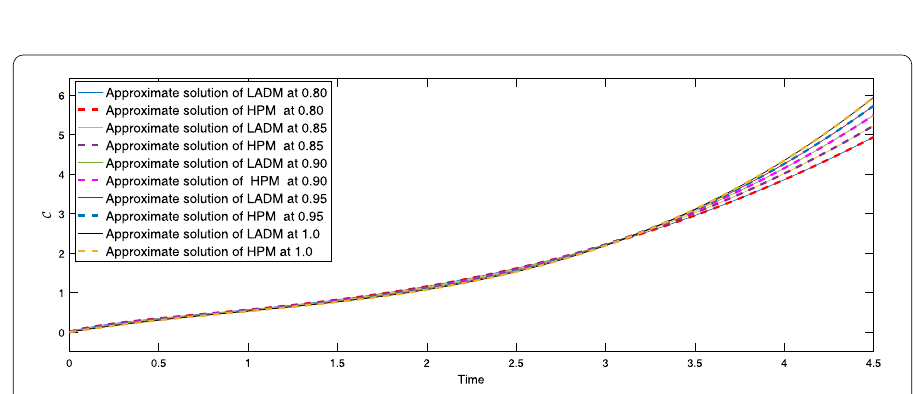
Figure 3 Comparison between the approximate solutions for C of model (3) for various fractional orders up to first three